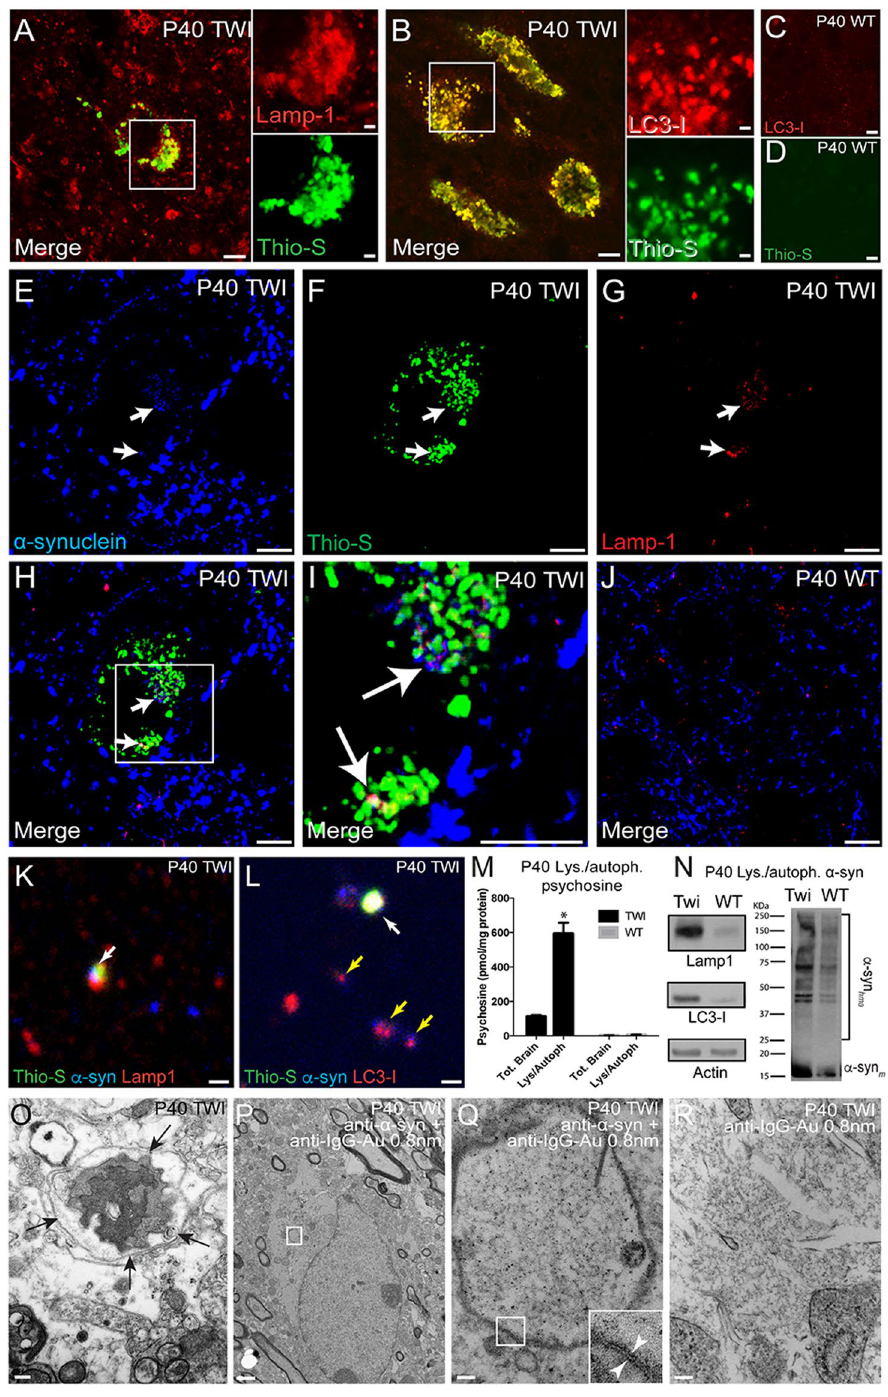
Figure 3. Psychosine and α -synuclein subcellular localization in vivo . Thioflavin-S (thio-S)-positive deposits in the P40 TWI brain co-localized with both the lysosomal marker Lamp-1 ( A ) and the autophagosomal marker LC3-I ( B ). TWI autophagosomes were enlarged compared to WT ( C ) and no aggregated thio-S material was detected in the WT brain ( D ). Anti- α -synuclein antibodies co-localized intracellularly with thio-S and the lysosomal marker LAMP-1 ( E – I , arrows). Thio-S-positive α -synuclein was not detected in WT tissue ( J ). Isolation of lysosomes further confirmed α -synuclein co-localization with enriched lysosomes ( K ) and autophagosomes ( L ) while also staining positive for thio-S ( K , L white arrows). Not all organelles that co-localized with α -synuclein were positive for thio-S ( L , yellow arrows). Psychosine levels measured in total lysate and isolated lysosomes showed an accumulation in TWI that was significantly enriched in the lysosome/ autophagosome fraction compared to the total lysate (n = 3, p < 0.05, ANOVA) ( M ). Fractions enriched in lysosomes and autophagosomes from TWI and WT brains showed an elevated level of Lamp-1 and LC3-I in addition to high-molecular-weight aggregates of α -synuclein in TWI ( N ). Ultrastructure EM